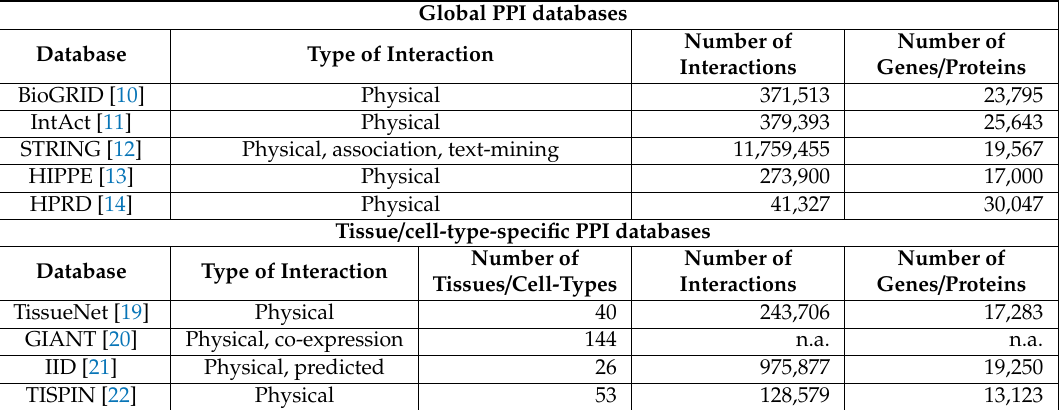
Table 1. Databases providing human protein-protein interaction